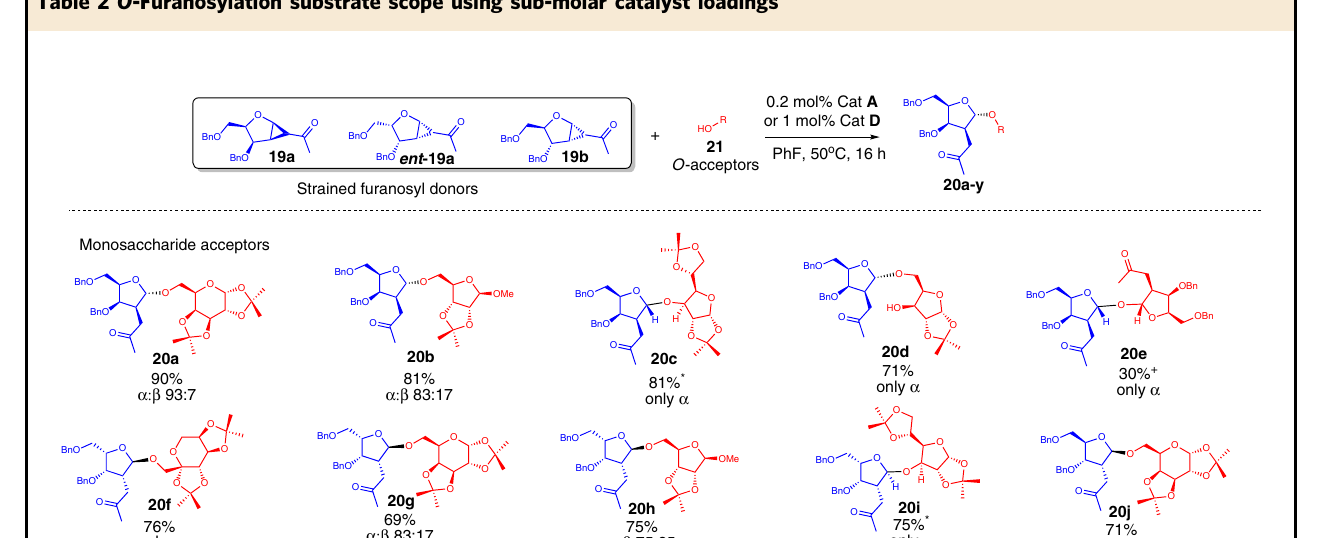
Sterol acceptors-glycolipids type